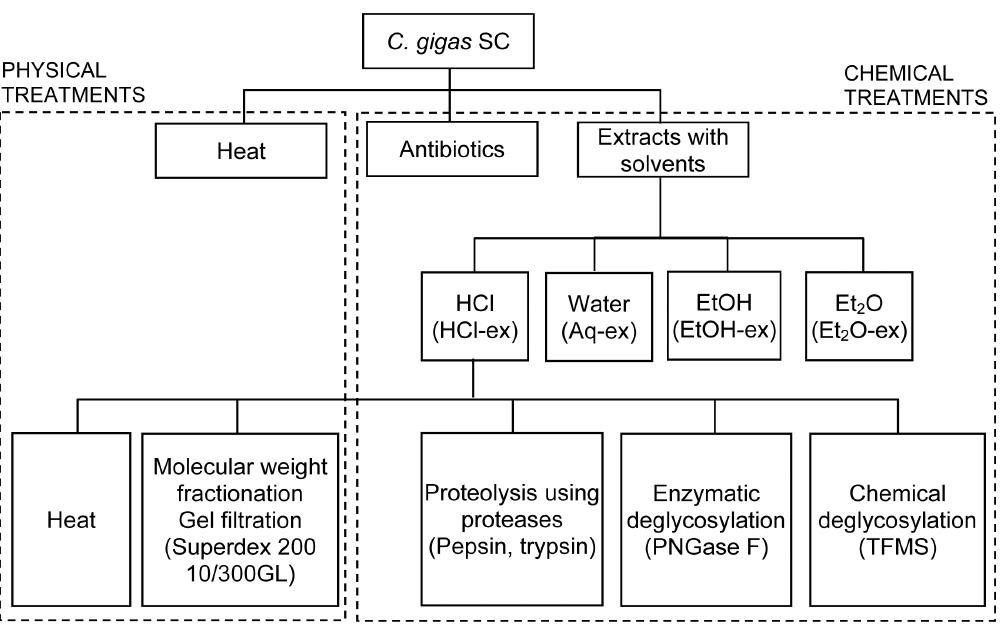
Figure 1. Experimental design for the characterization of the settlement inducer in C.gigas SC.